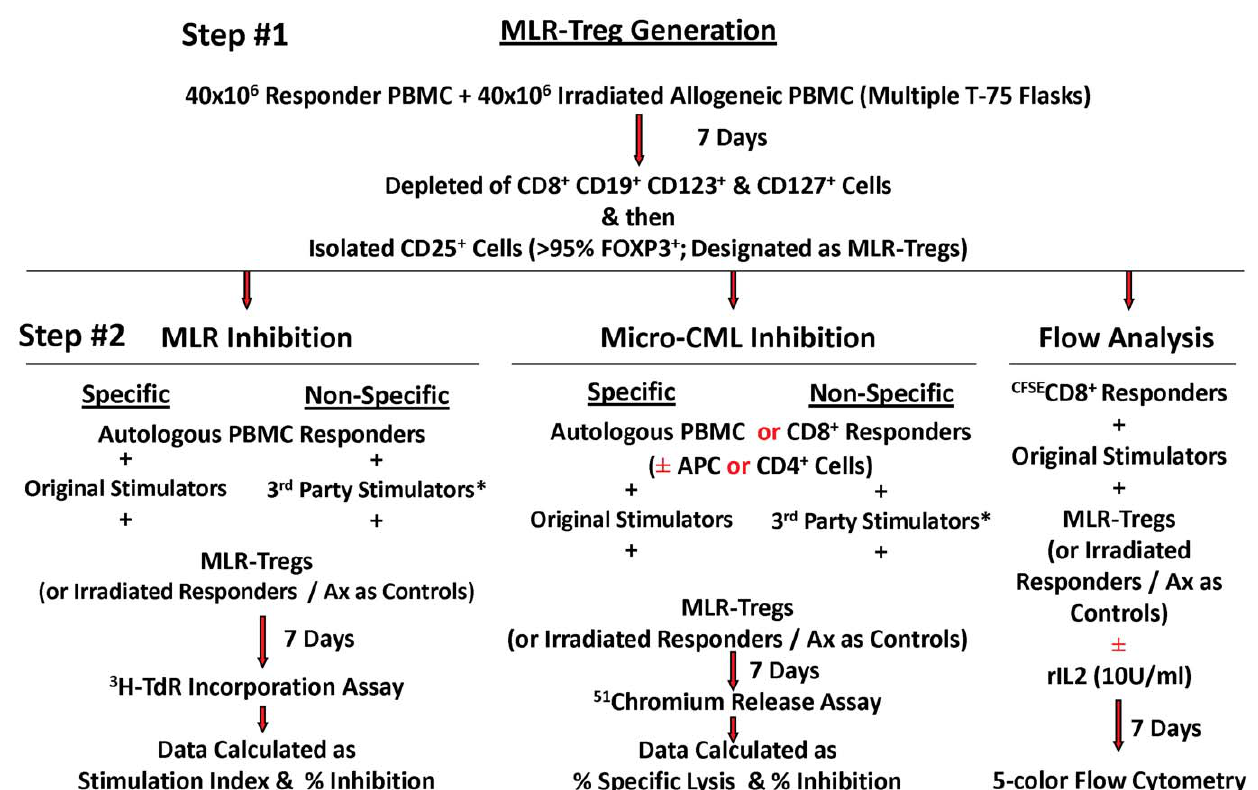
Figure 1. Flow diagram depicting the culture system for the generation of MLR-Tregs (step # 1) and their utilization in various MLR, micro- CML and flow cytometric assays (step # 2).